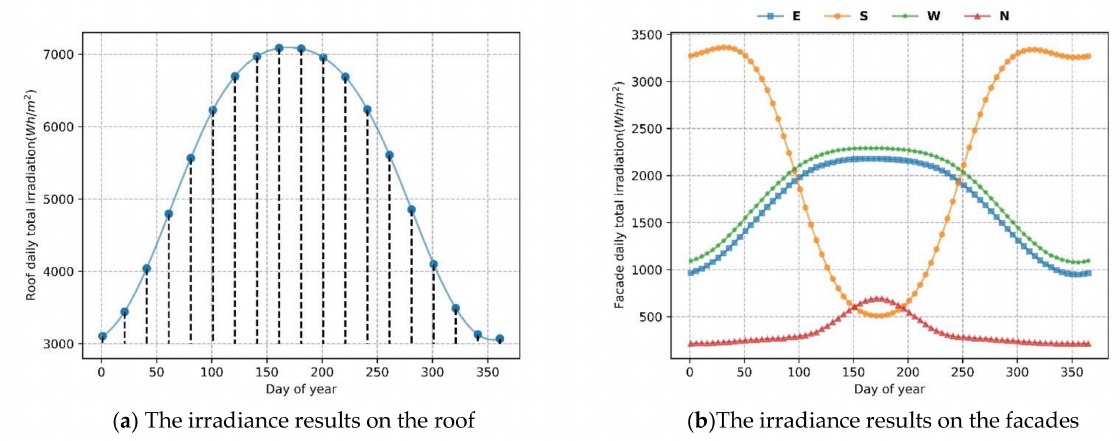
Figure 17. Polynomial interpolation of the daily total irradiation.